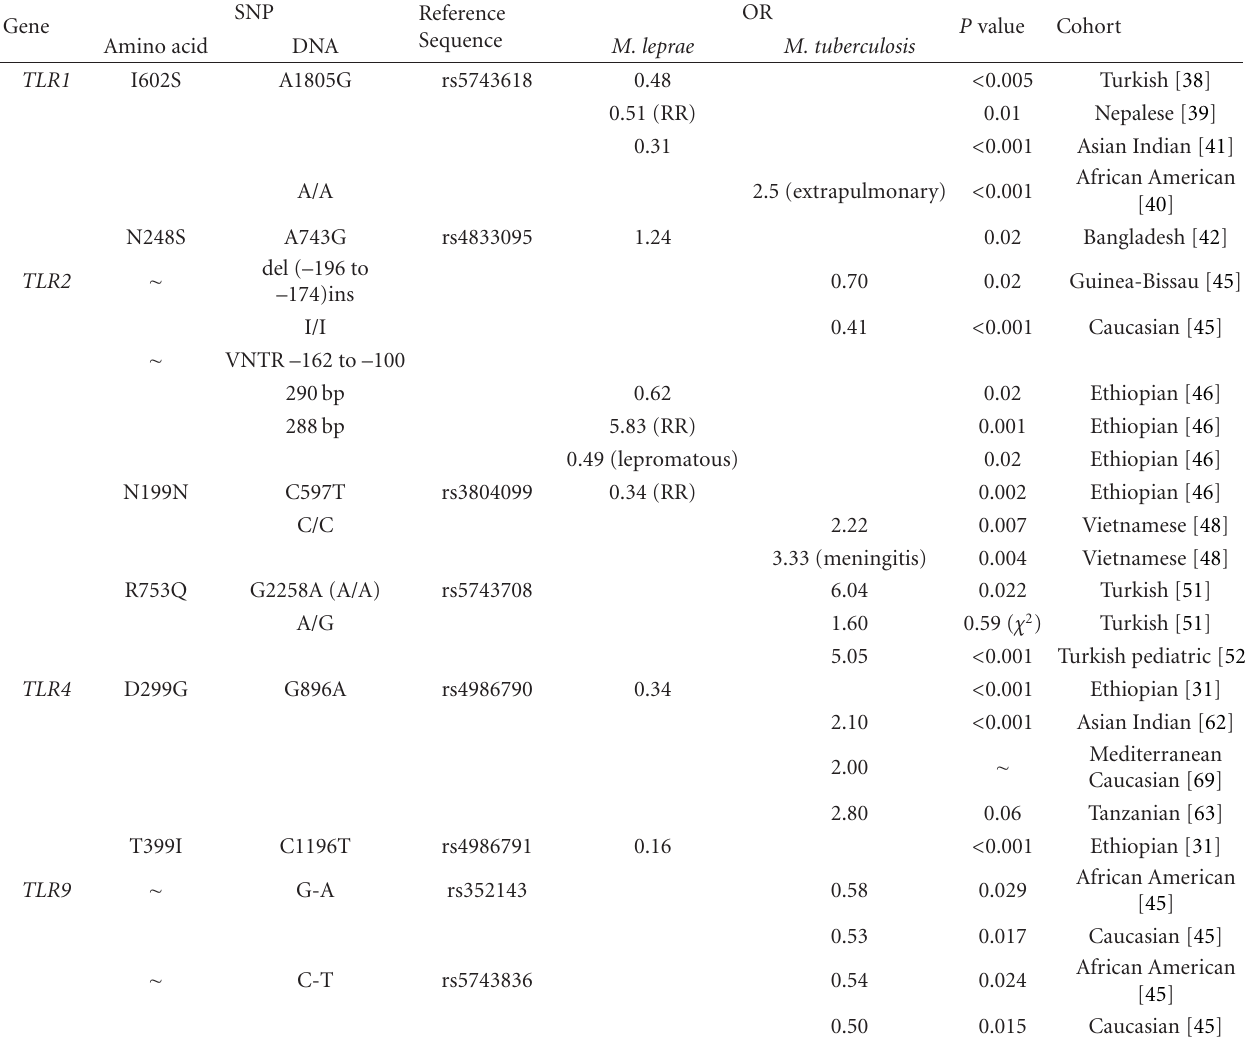
Table 1: TLR polymorphisms are organized by receptor, genotype, phenotype, and cohort. The odds ratio (OR) measures the strength of association between genotype and disease. A ratio less than 1 depicts the degree of protection and a ratio greater than 1 depicts the factor of increased susceptibility. Reference numbers are included with the associated cohort. RR: reversal reaction; del: deletion; ins: insertion; VNTR: variable number tandem